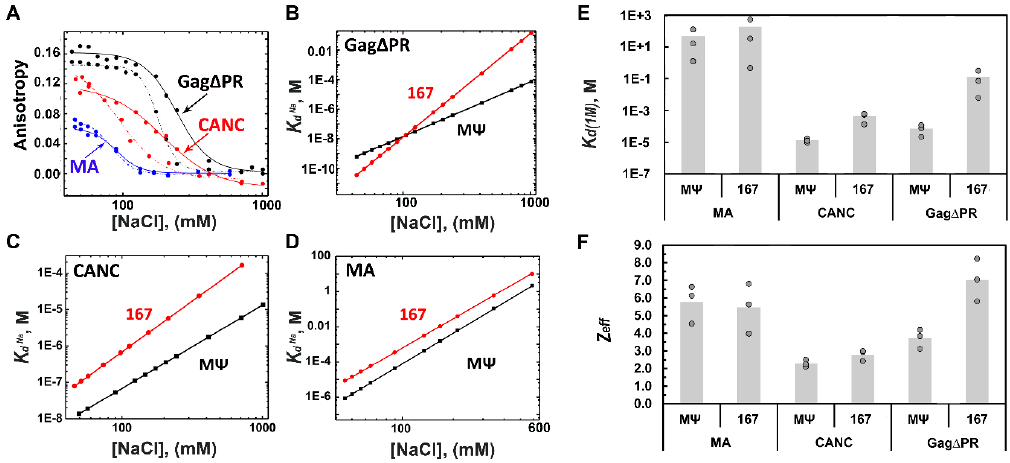
Figure 2. ( A ) Salt dependence of RSV Gag ∆ PR, RSV CANC (construct lacking RSV MA, p2, p10, and PR), and RSV MA binding to RSV M Ψ (solid curves) and RSV 167 (dashed curves). Data from panel A are re-graphed in log-log plots of the apparent binding affinity ( K d ) as a function of NaCl concentration for RSV Gag ∆ PR ( B ); RSV CANC ( C ); and RSV MA ( D ); Bar graphs of K d(1M) values ( E ) and Z eff values ( F ) were determined by salt-titration assays using the indicated RSV proteins and RNAs. K d(1M) values describe the nonelectrostatic component of binding and Z eff values describe the electrostatic component of the protein–nucleic acid interactions [46]. Values of three trials performed in each case are shown with the height of the bar indicating the mean value. Table 1. Binding parameters determined from fluorescence ‐ anisotropy (FA) salt ‐ titration assays with variants.